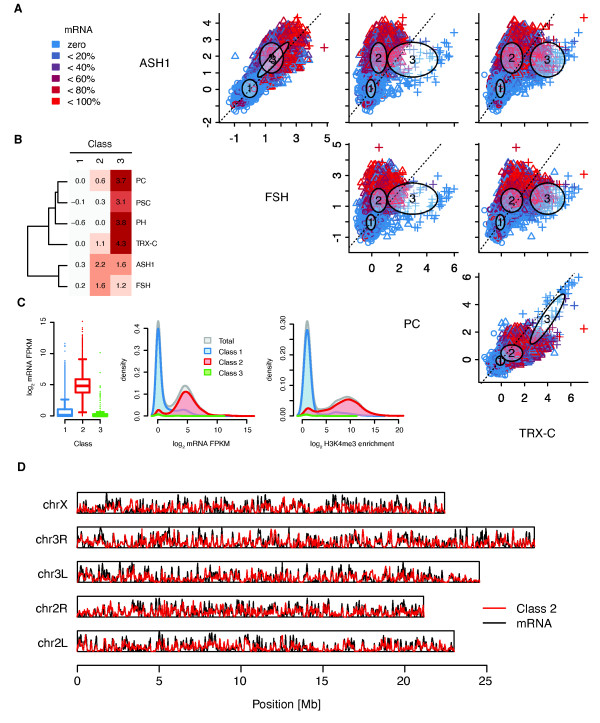
TrxG/PcG binding profiles are predictive for gene regulatory states. A sparse Gaussian Mixture Model (sGMM) emitting class assignment (1, 2, and 3) was fitted to ChIP-seq enrichment data for ASH1, FSH, TRX-C, PC, PH, and PSC. Normalized enrichments relative to Input were calculated for the 1-kb window centered at known TSS. (A) Pairs plot of the fitted model in selected dimensions; each plotting symbol represents a TSS window (class 1 = circle, class 2 = triangle, class 3 = plus sign); color-coding of plotting symbols indicates corresponding gene expression level (see color key for details). Numbered ellipses denote mean and variance of each class in the plotted dimensions. (B) Class 1 genes are characterized by the absence of TrxG/PcG proteins at the promoter. Class 2 and class 3 genes are cobound by ASH1 and FSH, in addition class 3 genes display strong PRC1 and TRX-C enrichments. Heat map plotting class means (columns) over all model dimensions. Row clustering indicates proteins showing correlated changes between classes. (C) Class 1 and class2 genes are mostly inactive, while class 2 genes get transcribed. Boxplots display distribution of gene expression within each sGMM class. Graphs show density estimates for gene expression and H3K4me3 modification (1-kb window) within each sGMM class compared to all genes (total). (D) Class 2 signal density and mRNA signal density show strong spatial correlation across chromosomes. Plot shows kernel density estimations for class 2 predictions and discretized mRNA signal (log2 FPKM cut-off = 2.5) in 1-kb windows tiling chromosomes.